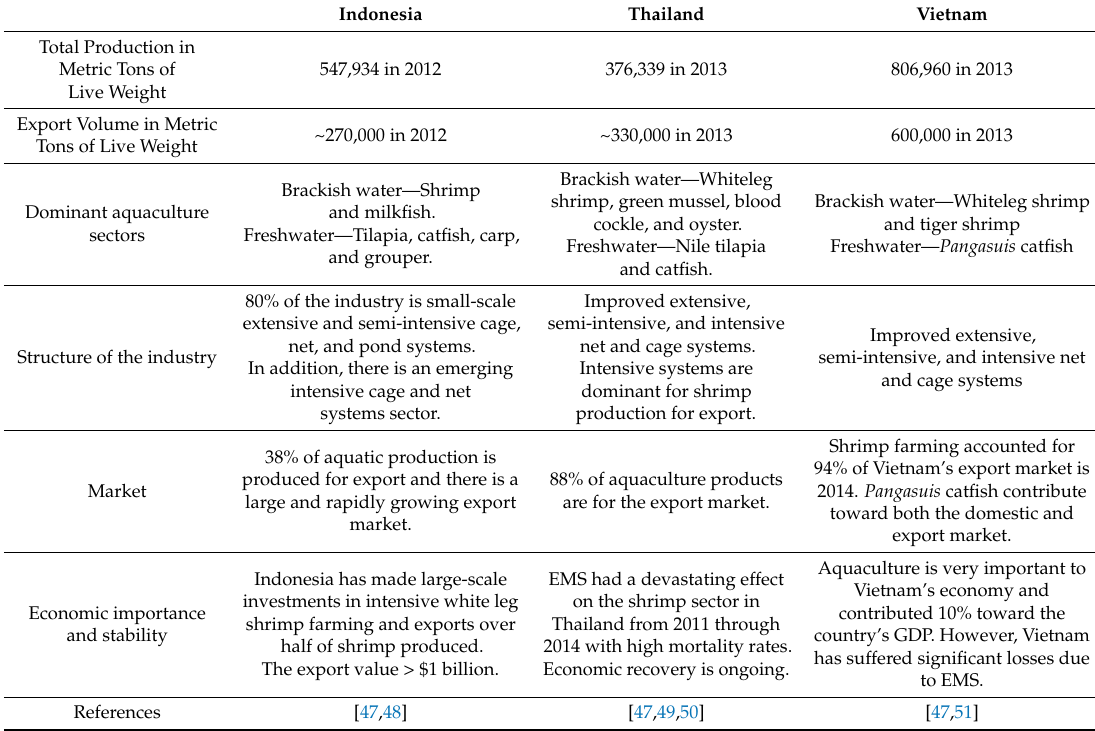
Table 5. An outline of the key characteristics of aquaculture production in Indonesia, Thailand, and